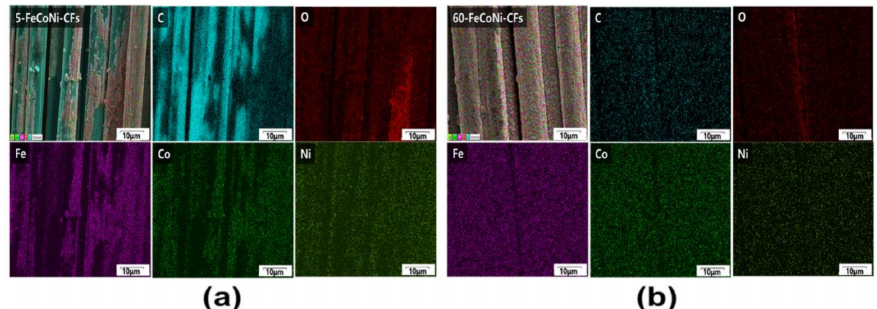
Figure 4. EDS-mapping images showing the chemical elements (blue: C, red: O, violet: Fe, green: Co, and khaki: Ni) distributions of ( a ) 5-FeCoNi-CFs and ( b )